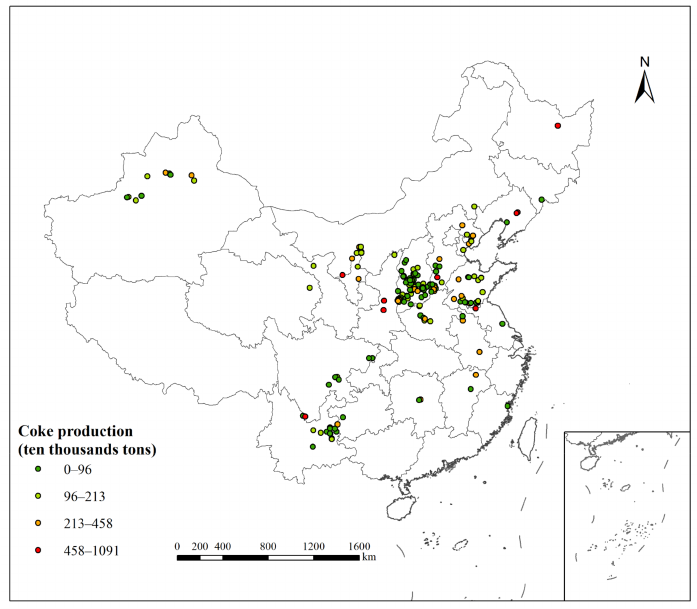
Figure 1. Distribution and scale of production of China’s independent coking industry in